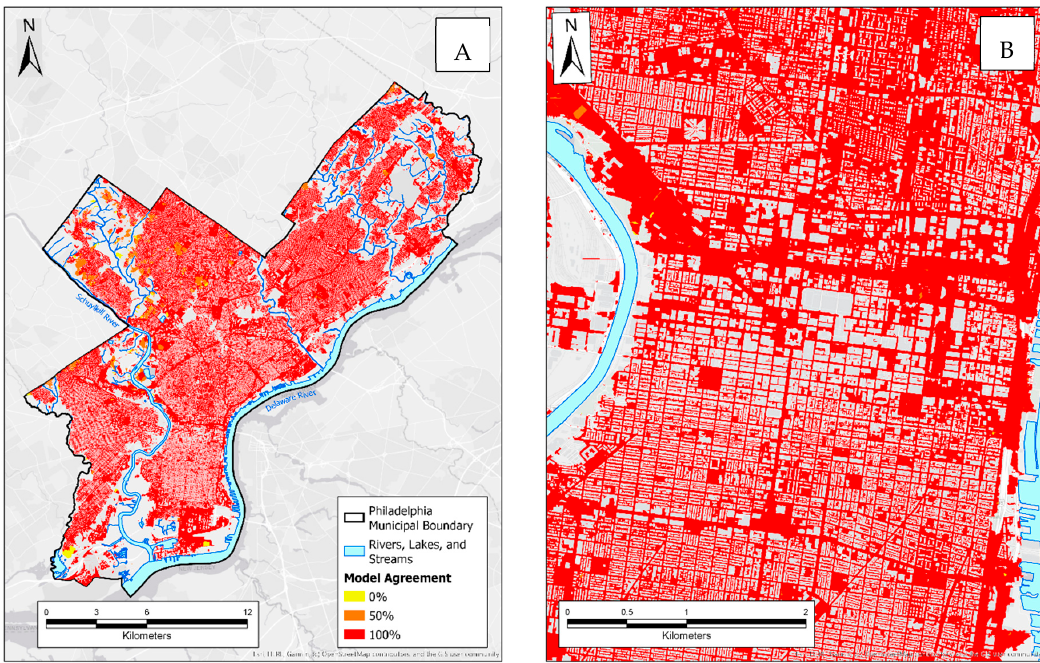
Figure 6. The Agreement index map of the surface runoff depth resulted from the 10-year, 24-hour storm is depicted for city of Philadelphia ( A ) and Center City ( B ). Red areas show where both the modified rational and NRCS methods agree on surface runoff depth exceeding the threshold of 5 cm.